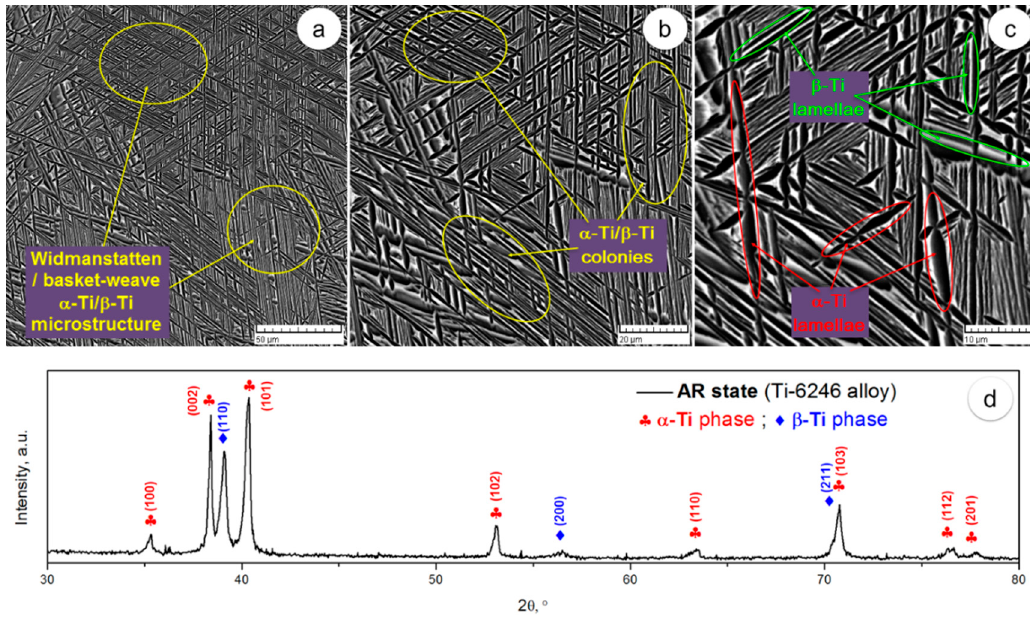
Figure 3. ( a – c ) SEM-back scattered electrons (SEM-BSE) images of as-received (AR) Ti-6246 alloy in different magnifications; ( d ) X-ray diffraction (XRD) spectra of as-received (AR) Ti-6246 alloy.